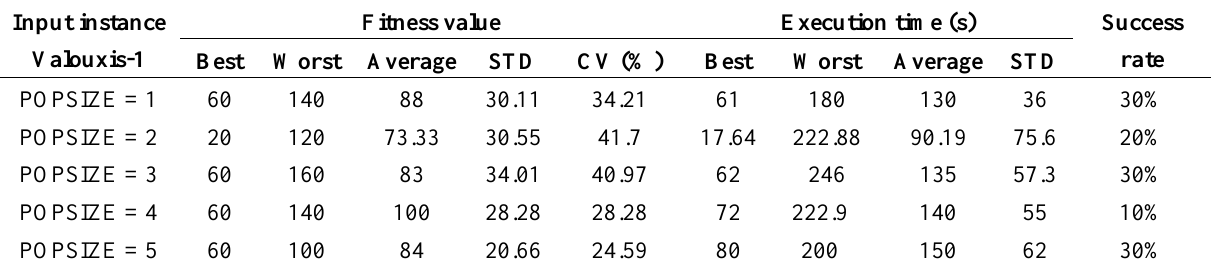
Table 6. Investigating the effect of population size for input instance, Valouxis-1.